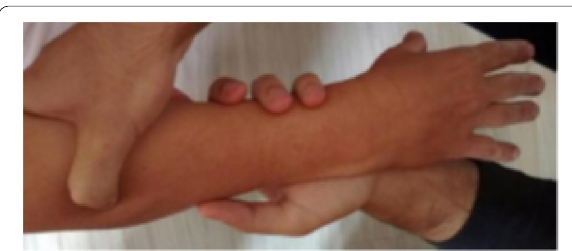
Fig. 2 Applying the transverse stretch on the upper limb with the thumb across the muscle